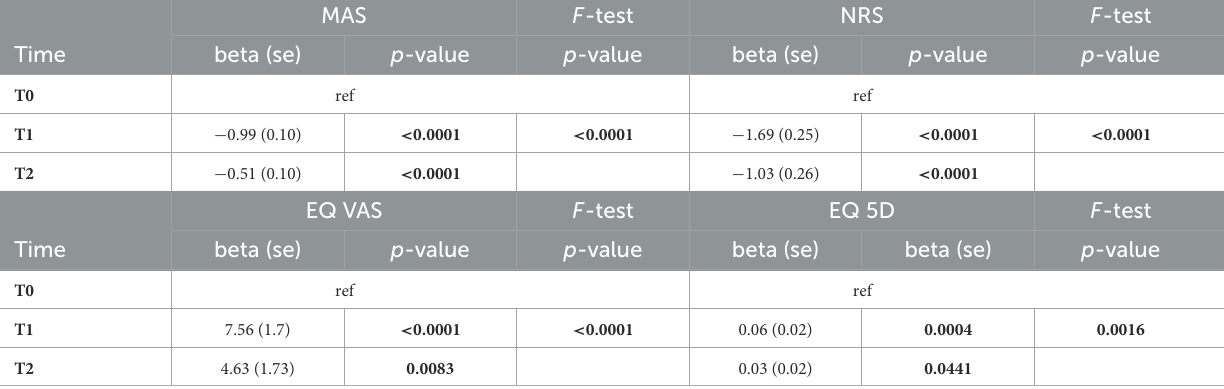
TABLE 2 Beta regression model of time effect on the considered variables (MAS, NRS, EQ VAS, and EQ-5D) up to T2.